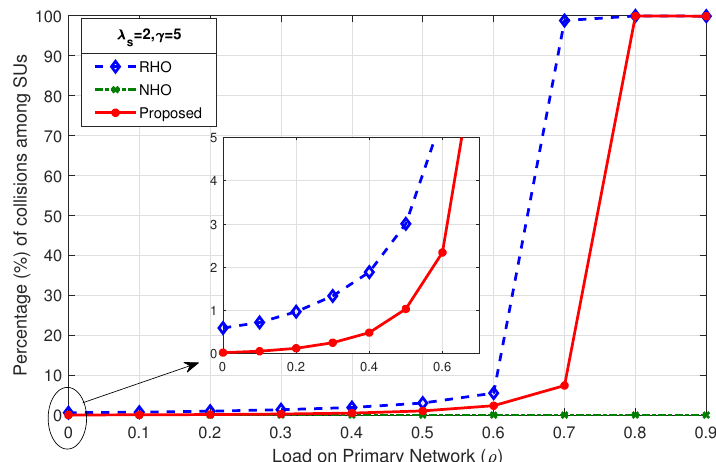
Figure 7. Comparison of percentage of collisions among SUs for λ s = 2, γ =